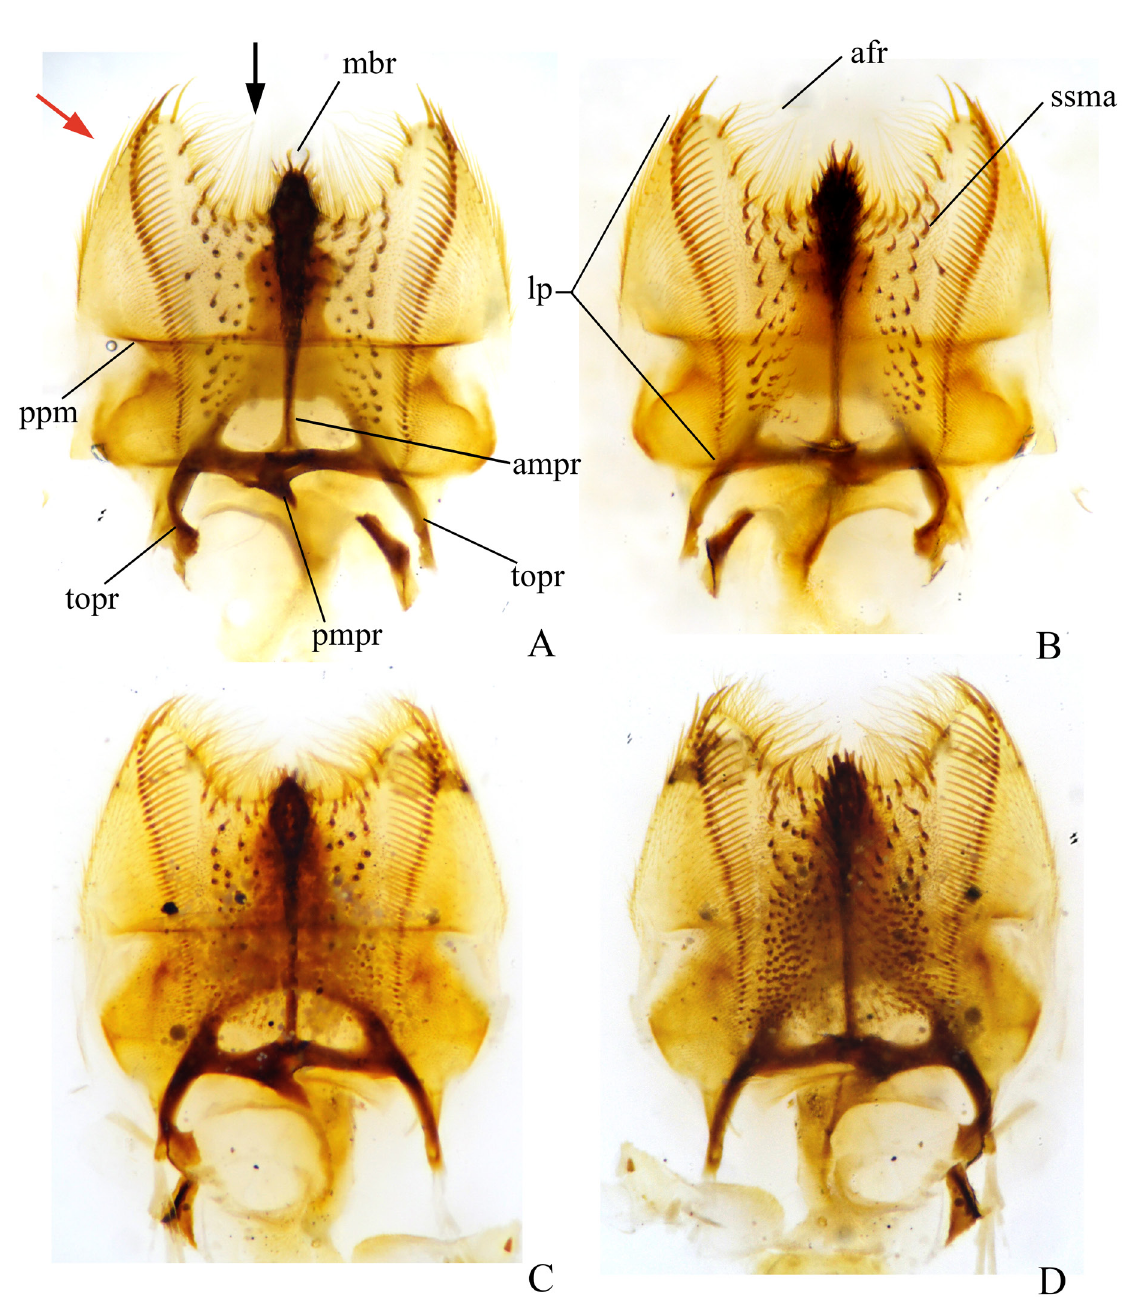
Fig. 8. Labrum. A‒B . Streblopus opatroides van Lansberge, 1874. A . Aboral surface (dorsal view). B . Oral surface (ventral view; epipharynx). C‒D . S. punctatus (Balthasar, 1938). C . Aboral surface. D . Oral surface. Note the many differences between the two species, particularly the much denser and shorter setation of the median area in S. punctatus , the much longer median brush of S. opatroides and the dissimilarities in the shape of the anterior epypharingeal margin. The black arrow shows the anterior margin of the labrum, while the red arrow indicates the anterolateral region. Abbreviations: afr = apical fringe of labrum; ampr = antero-median process of labral suspensorium; lf = lateral files; mbr = medial brush of labrum; pmpr = postero-median process of labral suspensorium; ppm = proplegmatium; ssma = socketed setae of median area; topr = tormal process of labral